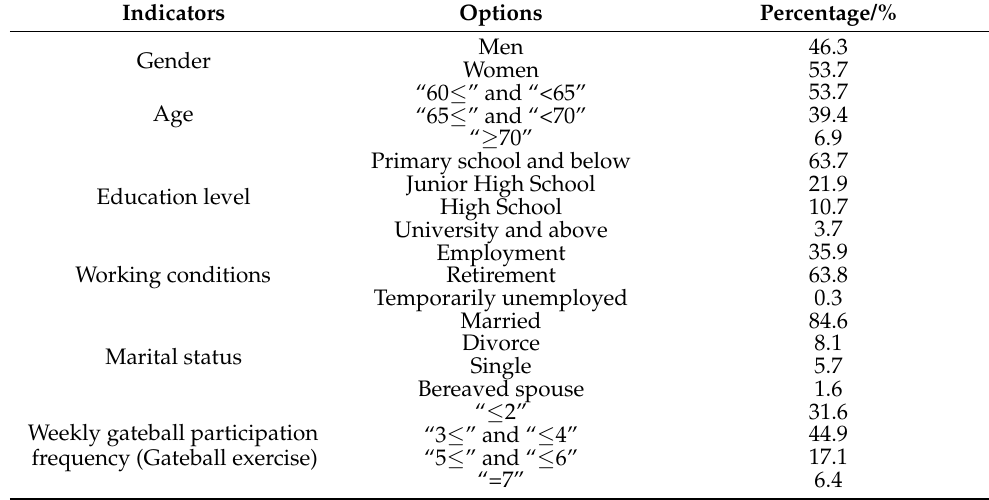
Table 1. Demographic features of the study sample.